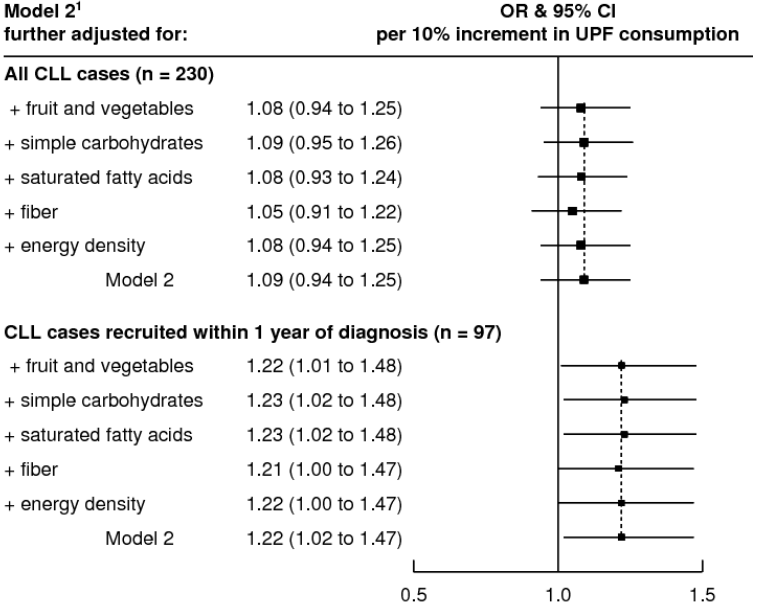
Figure 1. Association between a 10% increment in the consumption of ultra-processed food and drink and chronic lymphocytic leukemia in the MCC-Spain study, further adjusted for nutritional characteristics for all cases (top graph) and restricted to cases recruited within one year of diagnosis (incident; bottom graph). OR, odds ratio; 95% CI, 95% confidence interval; CLL, chronic lymphocytic leukemia; UPF, ultra-processed food and drinks. 1 Logistic regression adjusted for age, sex, province, educational level, family history of hematological neoplasms, ever worked in farming, physical activity, energy intake, ethanol intake and smoking status. Black squares and horizontal lines indicate the OR and 95% CI, respectively.